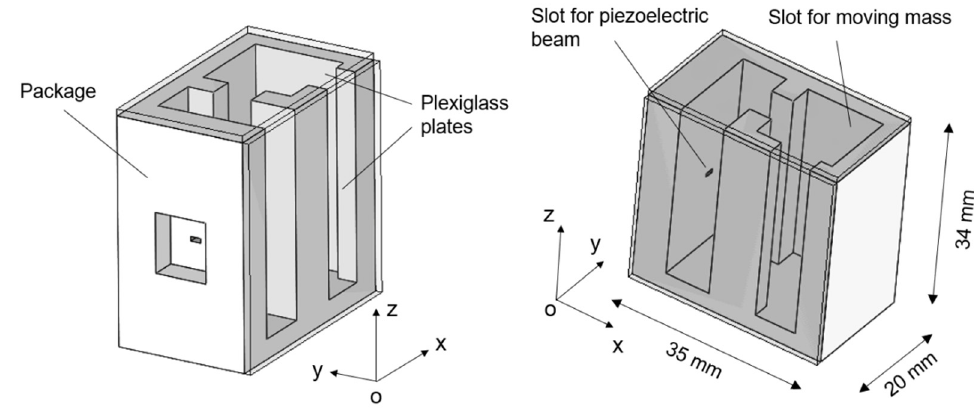
Figure 4. Illustration of the package of the piezoelectric energy harvester designed with Solidworks©.